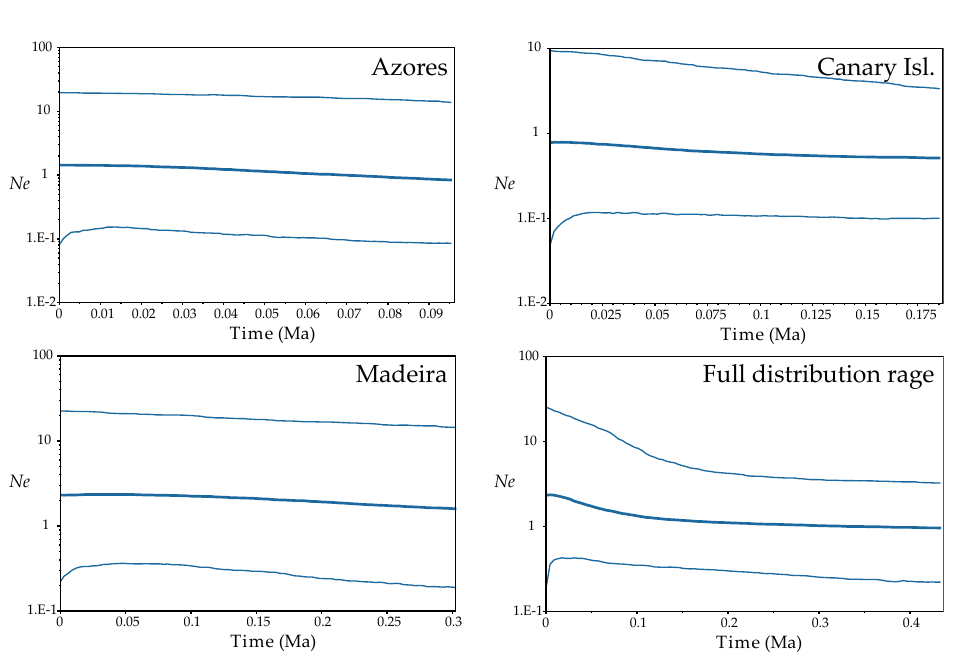
Figure 4. Demographic analyses (Bayesian Skyline Plots) based on coalescence considering each Macaronesian archipelago separately and the full distribution range of the species, inferred from ptDNA and implemented with BEAST. Plots depict changes in effective population size ( N e ) as a function of time (in million years ago, Ma); in each plot, the centre line is the median estimate, and the upper and lower lines delimit the highest posterior density (HPD) 95% confidence intervals for N e .